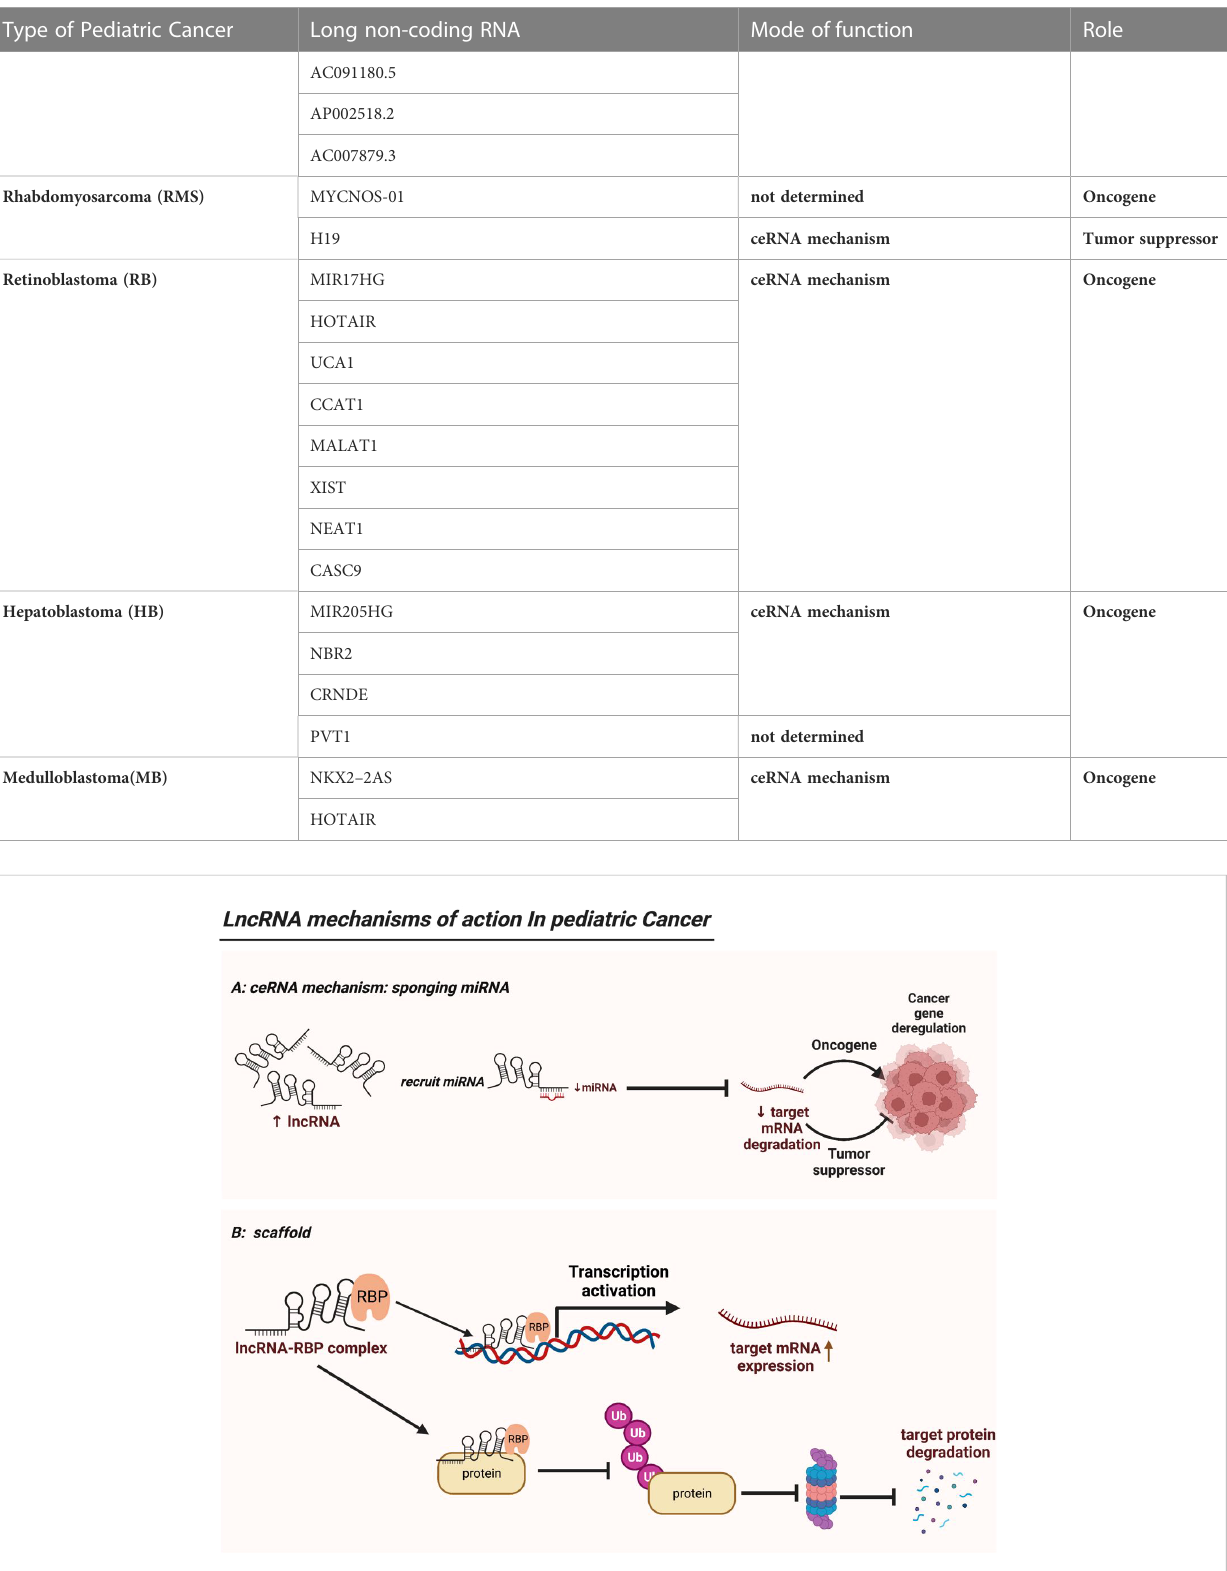
FIGURE 2 LncRNA mechanisms of action in pediatric cancer. (A) LncRNAs serve as ceRNAs by competitively occupying miRNAs ’ shared binding sequences, thus sequestering the miRNAs and altering the expression of their downstream target genes. (B) LncRNAs act as modular scaffolds. By interacting with RBP, lncRNA-RBP complex can bind to promoter region of a target gene thus driving its gene expression. In addition, the lncRNA-RBP complex can mediate or sequester ubiquitination of target protein, thereby regulating downstream protein expression.